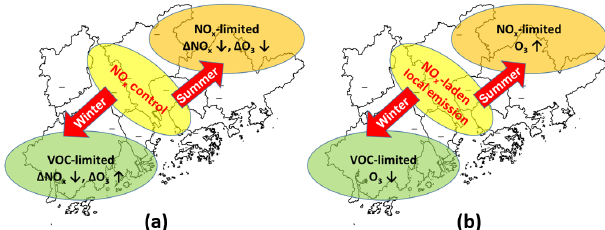
Figure 11. A conceptual diagram of the impacts of local emis- sions on (a) ozone concentrations and (b) their changing trends over the Pearl River Delta. Local NO x -laden emissions increase the ozone level (O 3 ↑ ) in the downwind northeastern PRD in sum- mer and fall, but the increase is suppressed due to the preferential NO x control ( (cid:49) NO x ↓ ), leading to a net ozone decrease ( (cid:49) O 3 ↓ ). In comparison, local emissions decrease the ozone level (O 3 ↓ ) in the downwind southwestern PRD in winter and spring, but the de- crease is also mitigated due to NO x control ( (cid:49) NO x ↓ ), leading to a net ozone increase ( (cid:49) O 3 ↑ ). Such a phenomenon is essentially governed by different ozone formation regimes in the northeastern (NO x -limited) and southwestern PRD